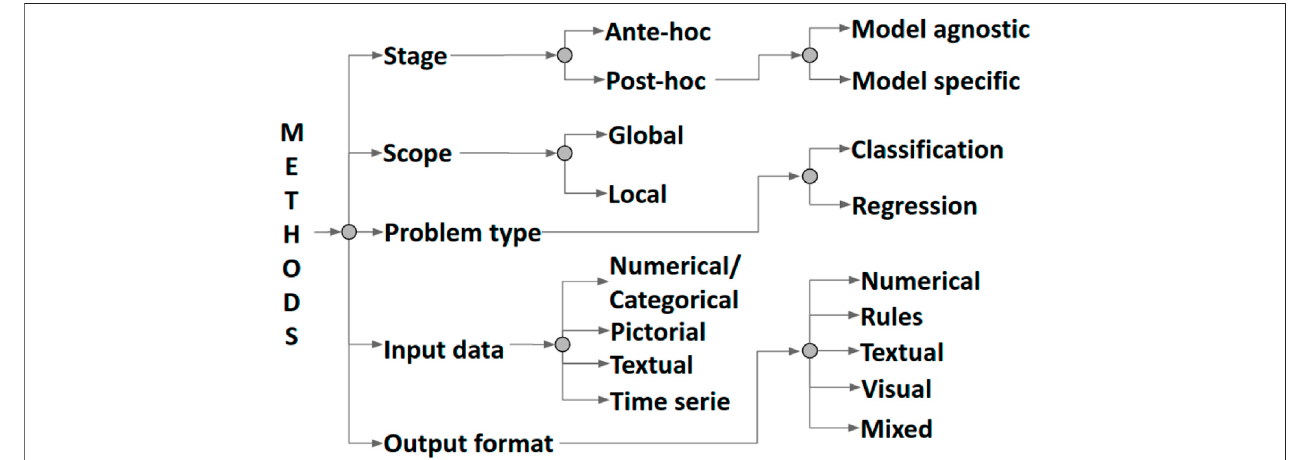
FIGURE 1 | Classi fi cation of methods for explainability proposed in Vilone and Longo (2021a).